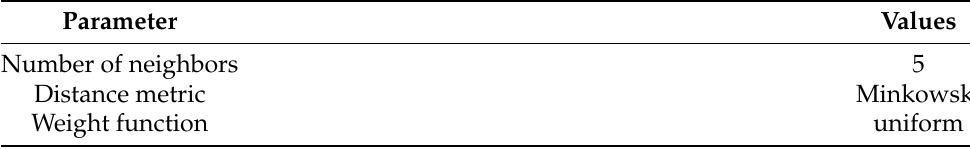
Table A2. Parameters of the k-NN classifiers.